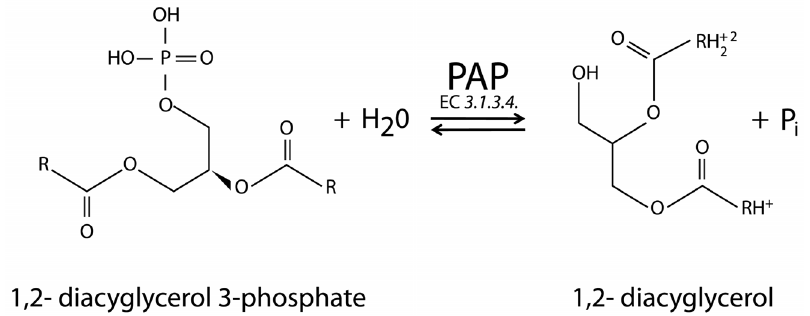
Figure 1. The schematic representation of enzymatic reaction catalyzed by PAP. The enzyme hydrolyzes the phosphoester linkage of PtdOH and generates DAG and P i